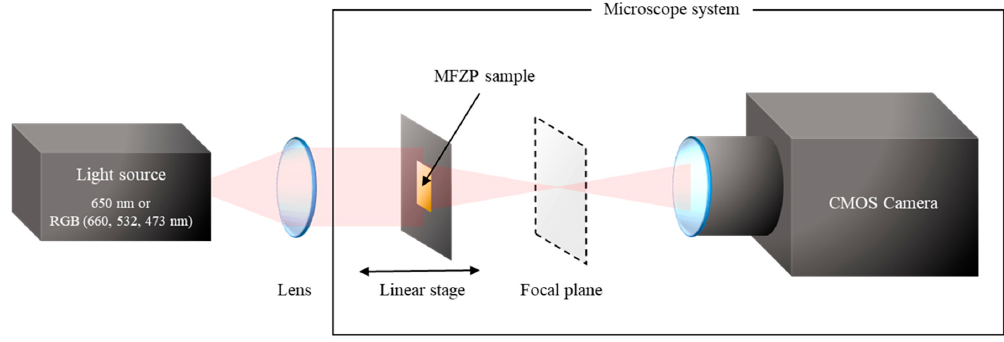
Figure 3. Schematic of the experimental arrangement for the characterization of MFZPs.